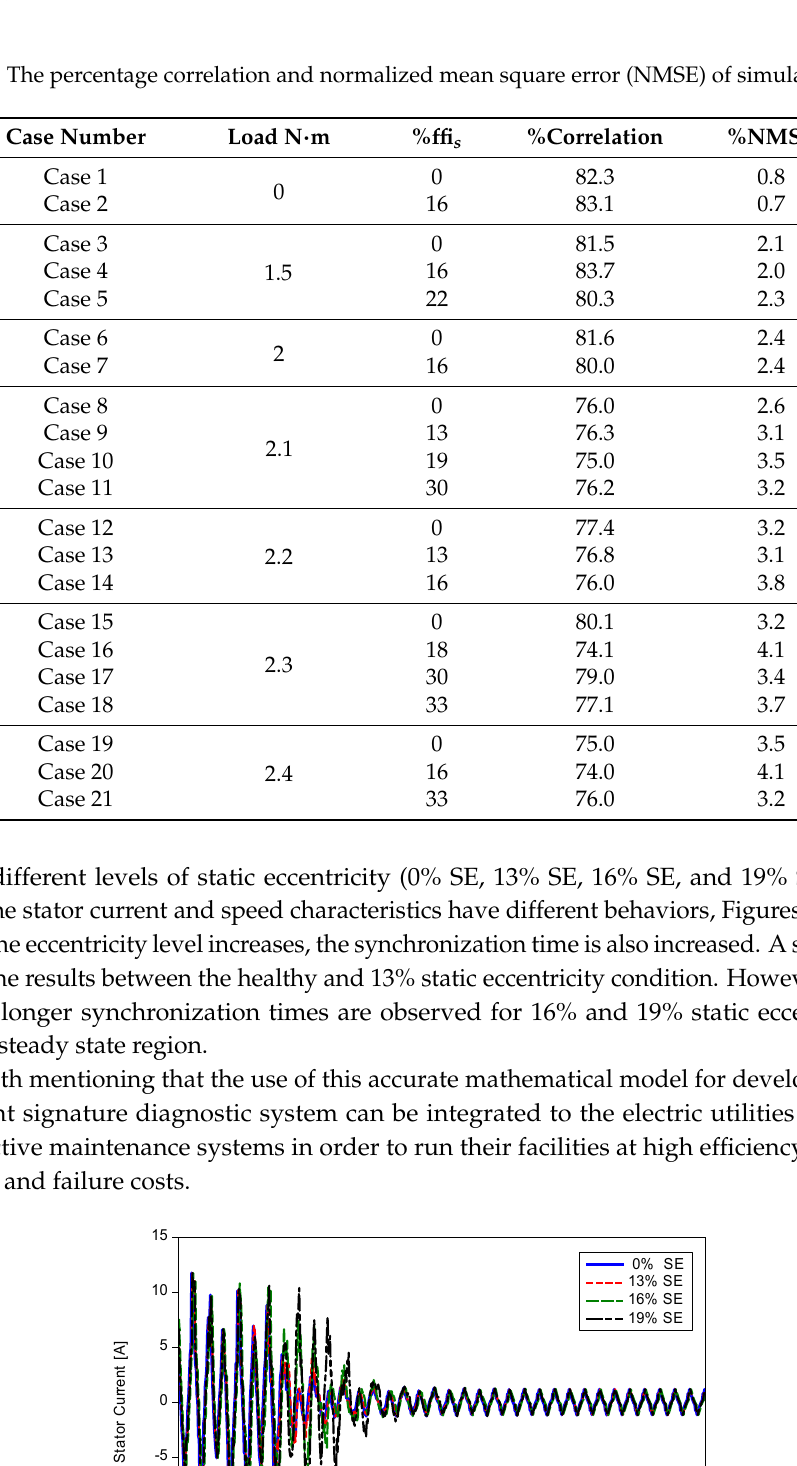
Figure 13. Speed under different values of SE. Sensitivity analysis is quite important to highlight the main sources of uncertainty and disturbances, which affects the simulation results. As such, and in order to test the robustness and sensitivity of the developed mathematical model, some parameters have been selected and varied. For example, the stator resistance (cid:1870) (cid:3046) and rotor equivalent resistance (cid:1870) (cid:3045) values are varied by ±10% of the original parameter value. The simulation is performed for 36 cases, which represent different loading conditions and eccentricity levels. The percentage normalized mean square error (%NMSE) is calculated to show the difference in results corresponding to the original and the modified parameter values. This comparison is conducted for the motor line current characteristic, which is the main output characteristic in this paper. Table 3 presents the percentage NMSE for each simulated case. The results show clearly the robustness of the proposed mathematical model against variation of these motor parameters. Table 3. The percentage NMSE of simulated cases. Eccentricity Percentage